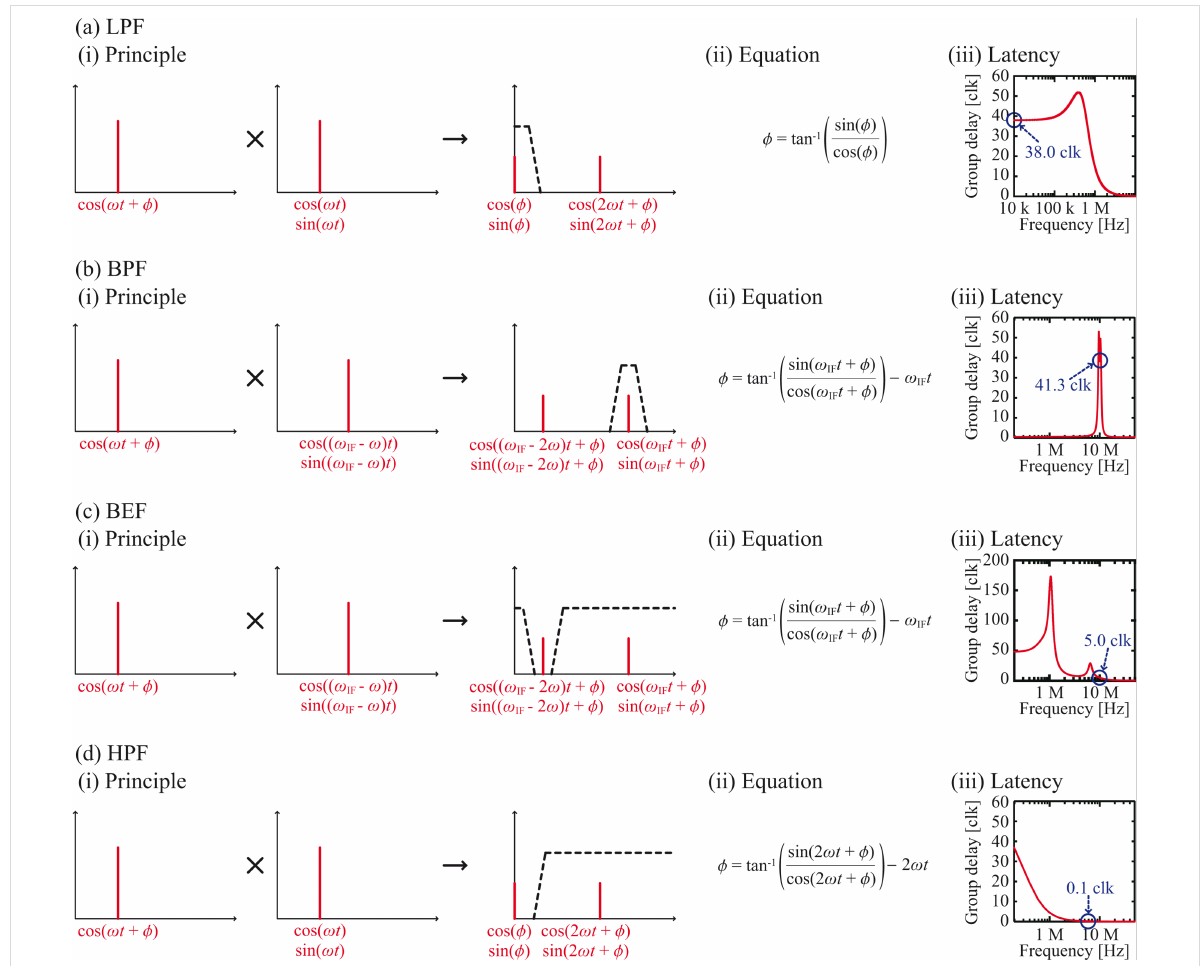
Figure 2: Basic concepts of different PC designs using (a) a LPF, (b) a BPF, (c) a BEF and (d) a HPF. (i) Principles. (ii) Equations for calculating . (iii) Examples of latency-versus-frequency curves. The design parameters were individually optimized for a 3 MHz input signal and 100 MHz clock fre- quency for digital signal